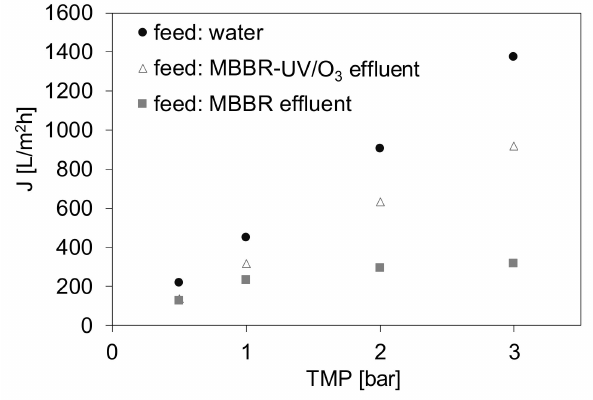
Figure 4. Influence of UV / O 3 treatment on MF permeate